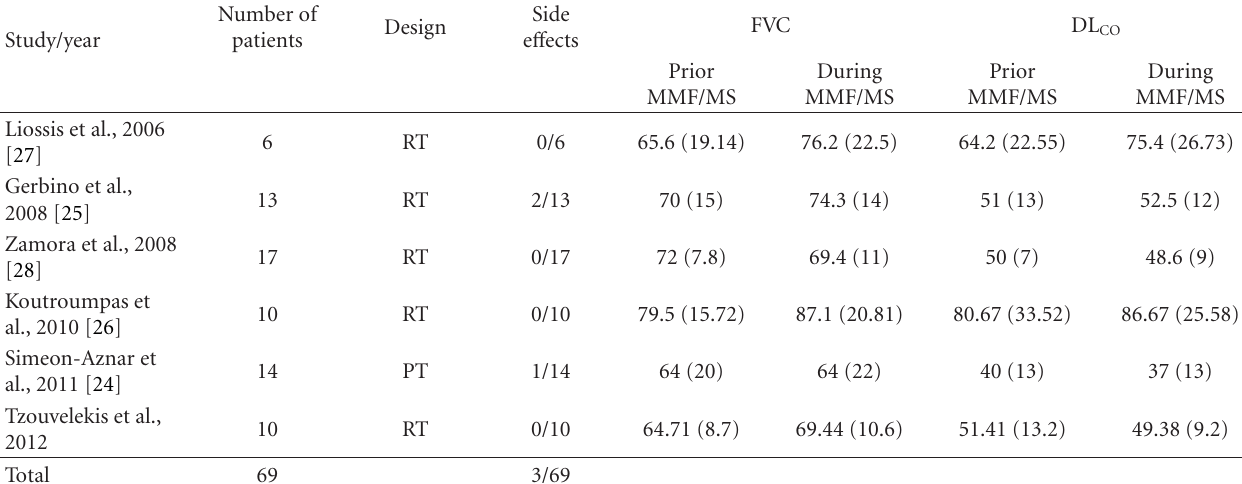
Table 2: Extracted data on outcomes of interest from all